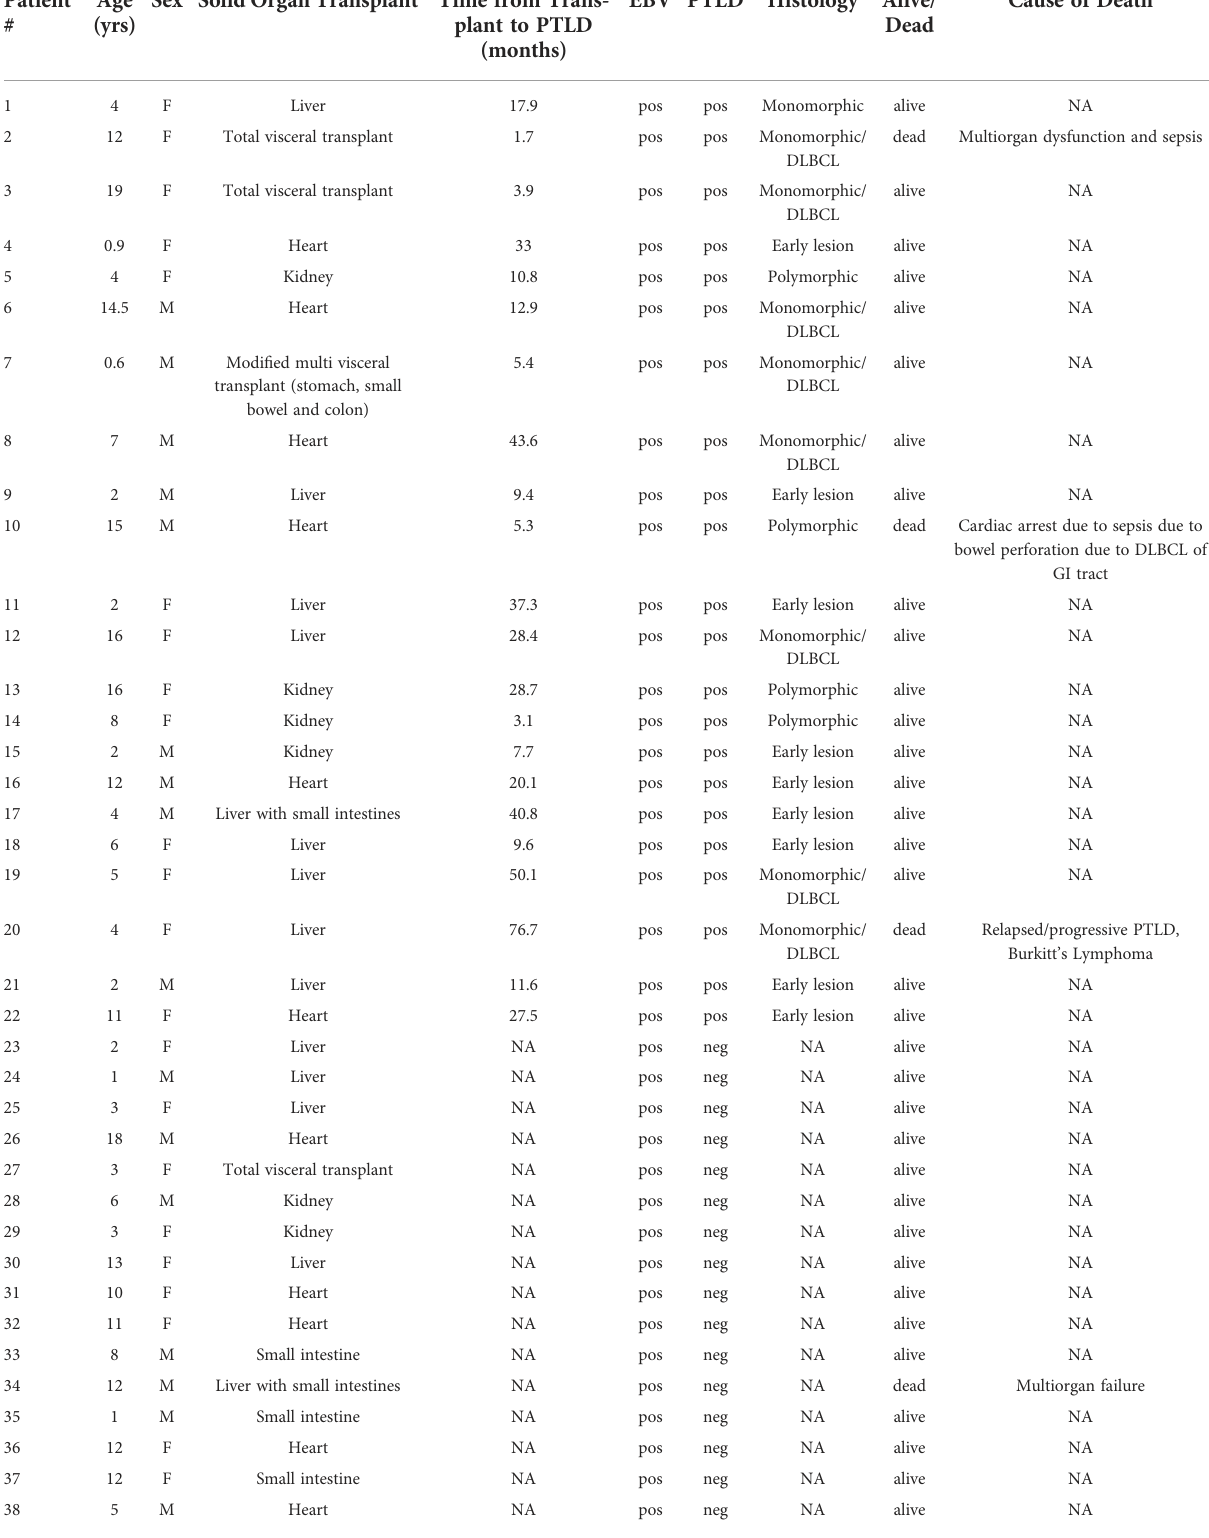
TABLE 1 Clinical information for pediatric Solid Organ Transplant recipient cohort. Patient